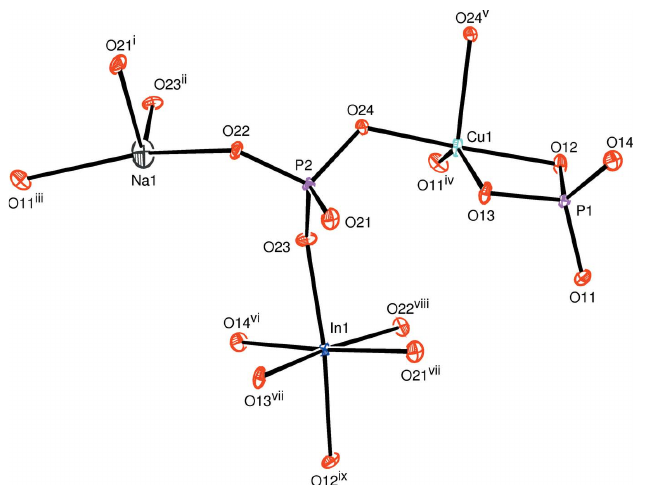
Figure 1 The principal building units in the crystal structure of NaCuIn(PO 4 ) 2 . Displacement ellipsoids are drawn at the 50% probability level. [Symmetry codes: (i) x + 1 , (cid:4) y (cid:4) 1 , z + 1 ; (ii) (cid:4) x + 1, (cid:4) y , (cid:4) z + 2; (iii) 2 2 2 (cid:4) x + 1 , y (cid:4) 1 , (cid:4) z + 3 ; (iv) x + 1 , (cid:4) y + 1 , z + 1 ; (v) (cid:4) x + 1, (cid:4) y , (cid:4) z + 1; (vi) x , 2 2 2 2 2 2 y , z + 1; (vii) (cid:4) x , (cid:4) y , (cid:4) z + 1; (viii) (cid:4) x +